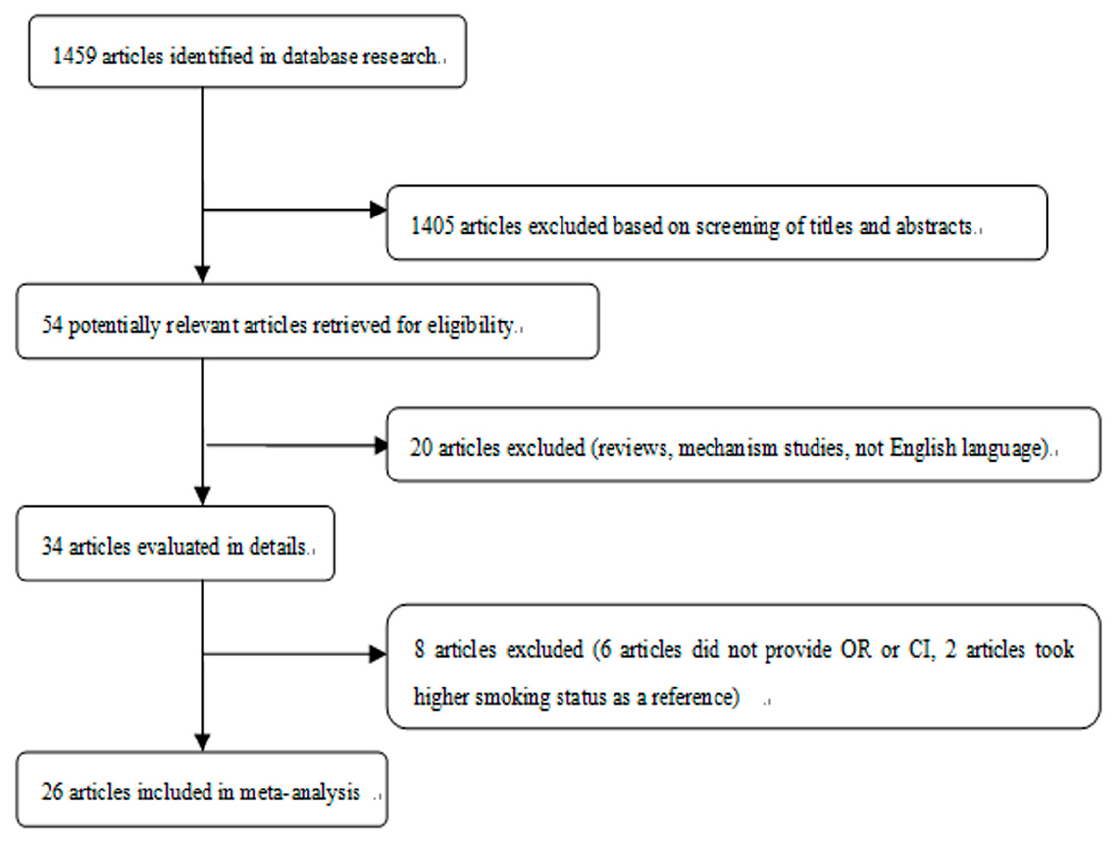
Figure 1. Study selection process.